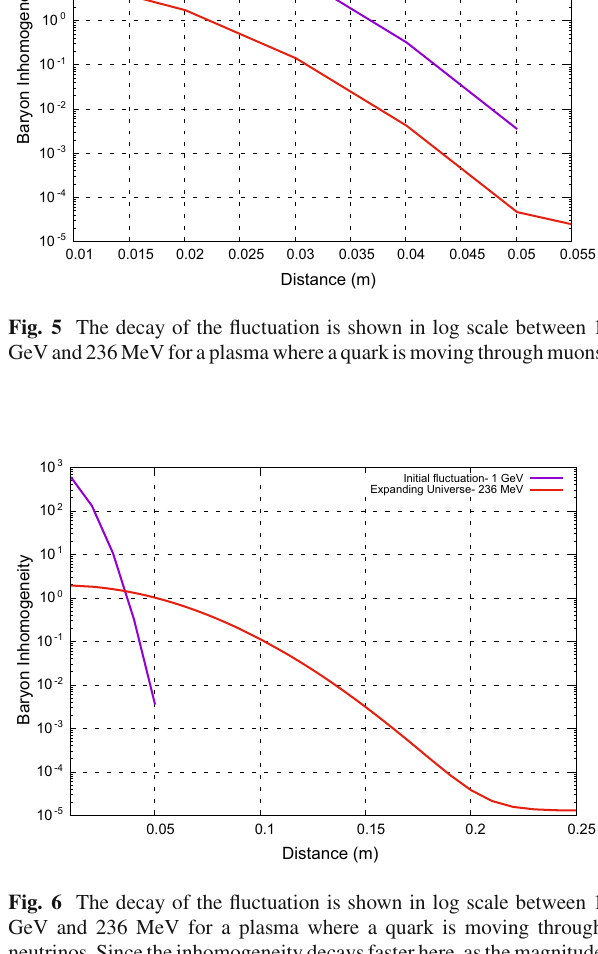
10 5 times the background density to survive till the quark hadron transition. Thus if we had an inhomogeneity at the electroweak scale with an amplitude less than 10 5 , it would be completely wiped out before the quark hadron